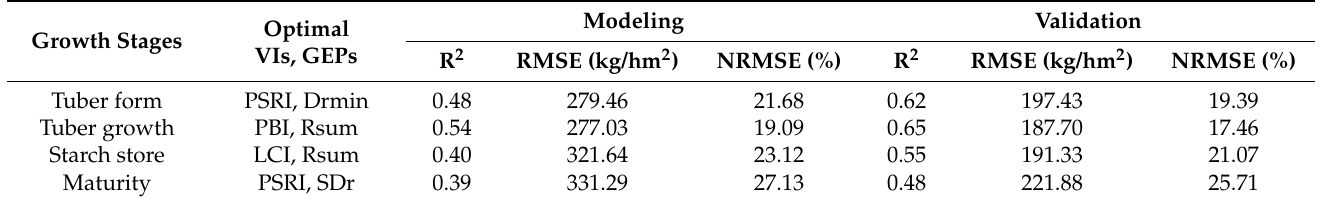
Table 5. Linear regression between (i) optimal VIs and optimal GEPs and (ii) potato AGB over the four growth